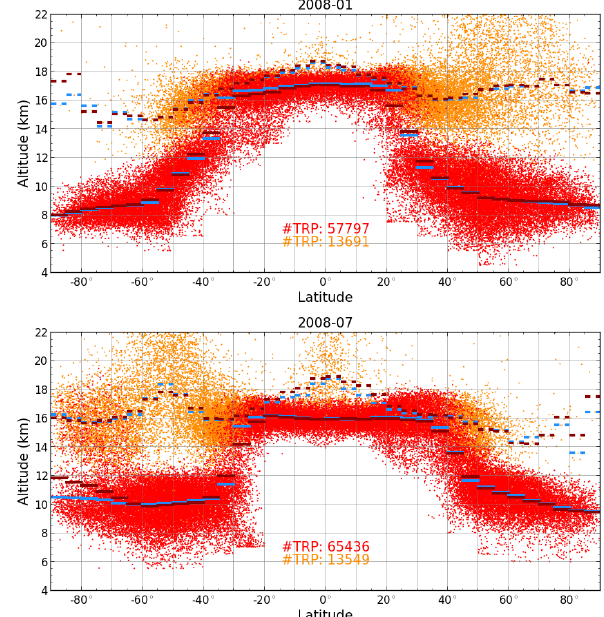
Figure 4. Temperatures of the first tropopause versus latitude for January (top) and July (bottom) from 2001 to 2013. Shown are the mean (dark red line), one standard deviation (bright red bars), median (blue bar), 25 to 75 quartile (box), and extreme values (whiskers) for 5 ◦ latitudinal bands.